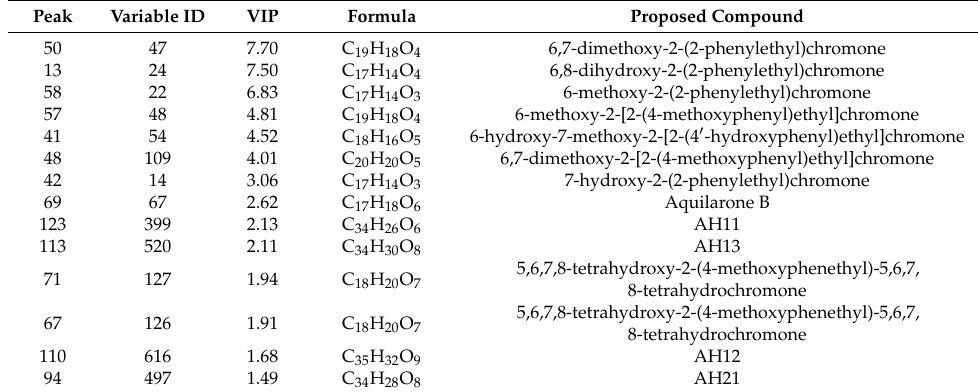
Table 3. Identified metabolites differing between wild and cultivated agarwood by UPLC-QTOF-MS. Peak Variable ID VIP Formula Proposed Compound 50 47 7.70 C 19 H 18 O 4 6,7-dimethoxy-2-(2-phenylethyl)chromone 13 24 7.50 C 17 H 14 O 4 6,8-dihydroxy-2-(2-phenylethyl)chromone 58 22 6.83 C 17 H 14 O 3 6-methoxy-2-(2-phenylethyl)chromone 57 48 4.81 C 19 H 18 O 4 6-methoxy-2-[2-(4-methoxyphenyl)ethyl]chromone 41 54 4.52 C 18 H 16 O 5 6-hydroxy-7-methoxy-2-[2-(4 1 -hydroxyphenyl)ethyl]chromone 48 109 4.01 C 20 H 20 O 5 6,7-dimethoxy-2-[2-(4-methoxyphenyl)ethyl]chromone 42 14 3.06 C 17 H 14 O 3 7-hydroxy-2-(2-phenylethyl)chromone 69 67 2.62 C 17 H 18 O 6 Aquilarone B 123 399 2.13 C 34 H 26 O 6 AH11 113 520 2.11 C 34 H 30 O 8 AH13 5,6,7,8-tetrahydroxy-2-(4-methoxyphenethyl)-5,6,7, 71 127 1.94 C 18 H 20 O 7 8-tetrahydrochromone 5,6,7,8-tetrahydroxy-2-(4-methoxyphenethyl)-5,6,7, 67 126 1.91 C 18 H 20 O 7 8-tetrahydrochromone 110 616 1.68 C 35 H 32 O 9 AH12 94 497 1.49 C 34 H 28 O 8